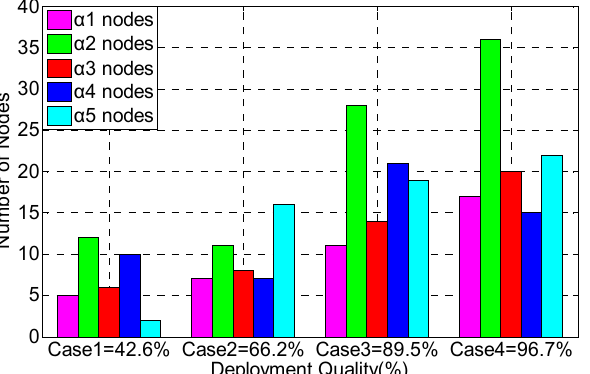
Figure 3. The sensor resource allocation of four cases and the event-driven deployment performance of the CONN algorithm.